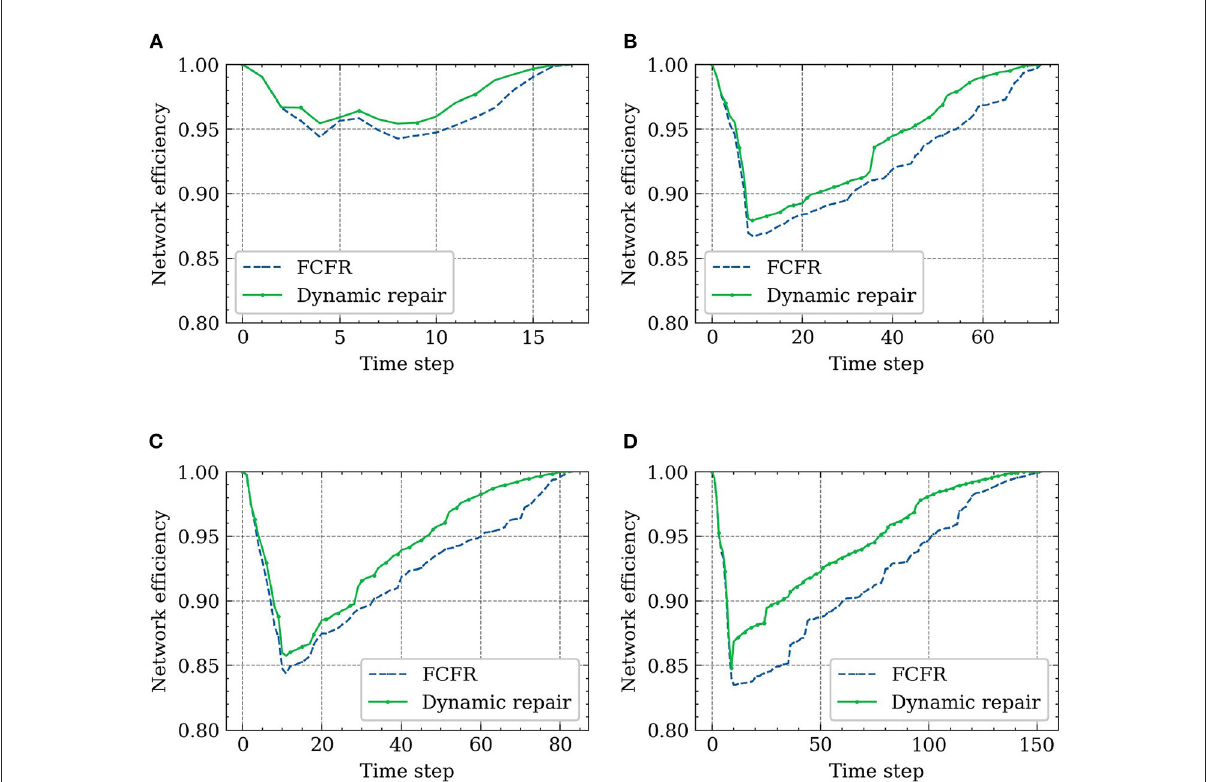
FIGURE16 Final recovery results with different traveling paths and recovery speeds. (A) Recovery results of SN path (R = 50 roads/time step). (B) Recovery results of WE path (R = 10 roads/time step). (C) Recovery results of SW-NE path (R = 10 roads/time step). (D) Recovery results of SE-NW path (R = 5 roads/time